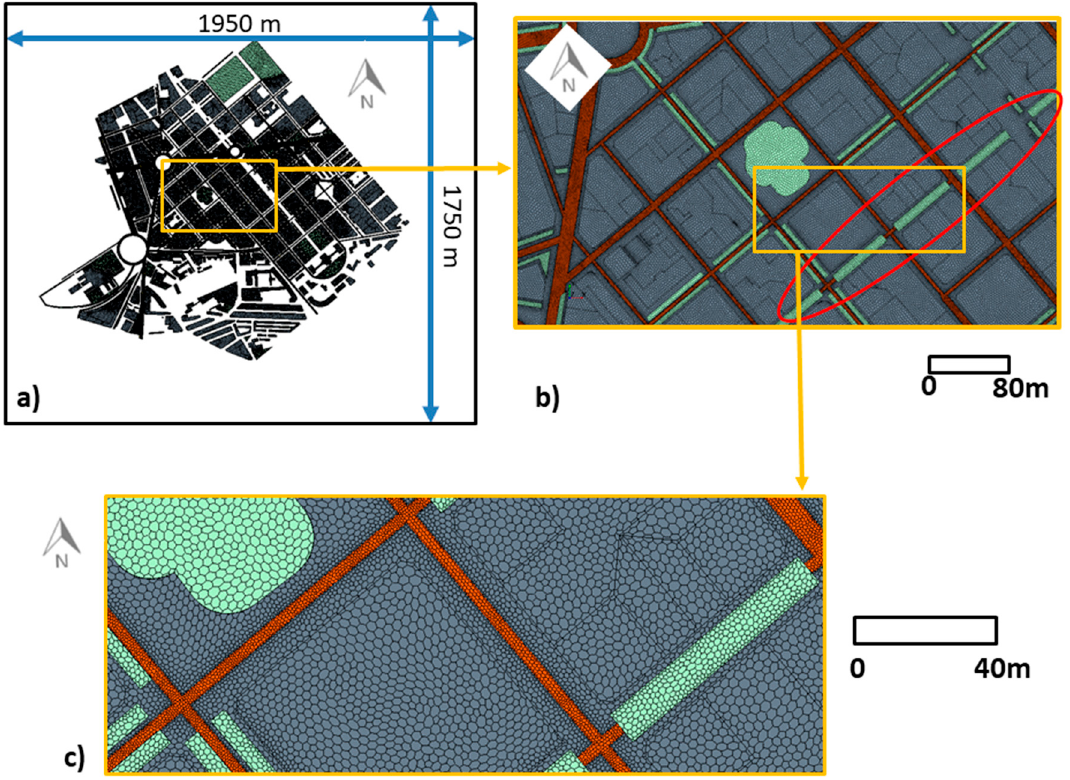
Figure 3. ( a ) Sketch of the CFD computational domain. ( b ) Details of geometry and new tress scenario (red line). ( c ) Details of mesh. Orange squares indicate the zone where zoom is done.